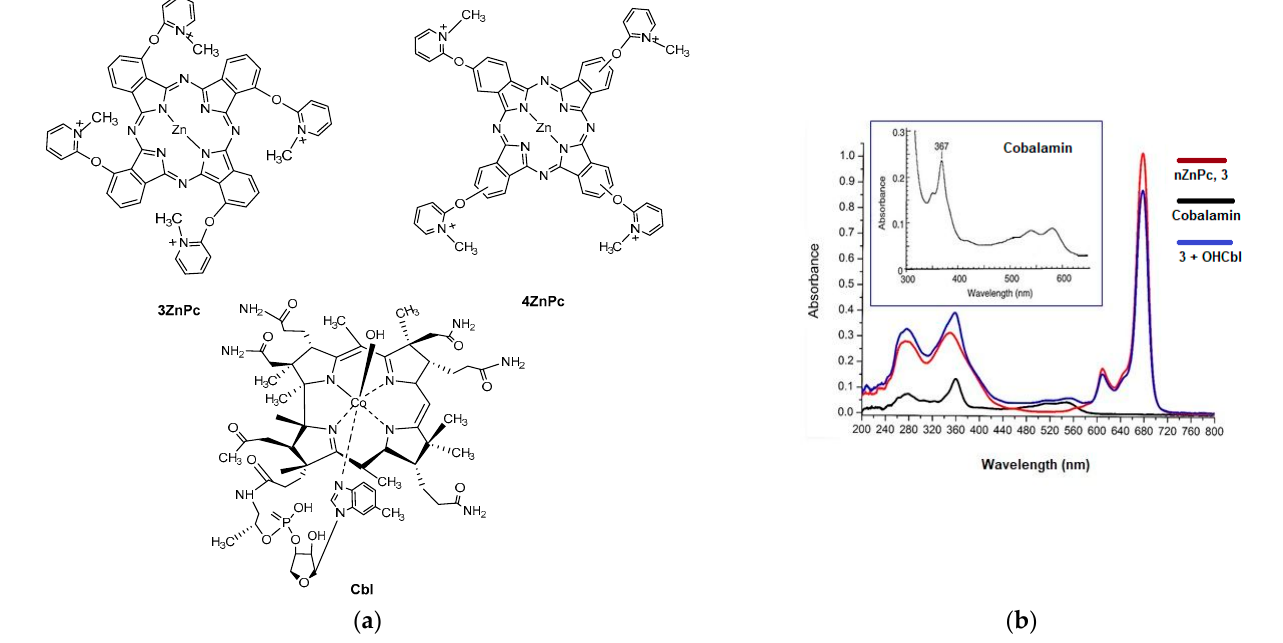
Figure 1. Structures of the studied two Zn(II)-phthalocyanines (3ZnPc and 4ZnPc) and hydroxycobalamin (Cbl) ( a ). The absorption spectra of compounds in a concentration of 10 − 5 M in DMSO (the spectrum of Cbl on top is magnified) ( b ).